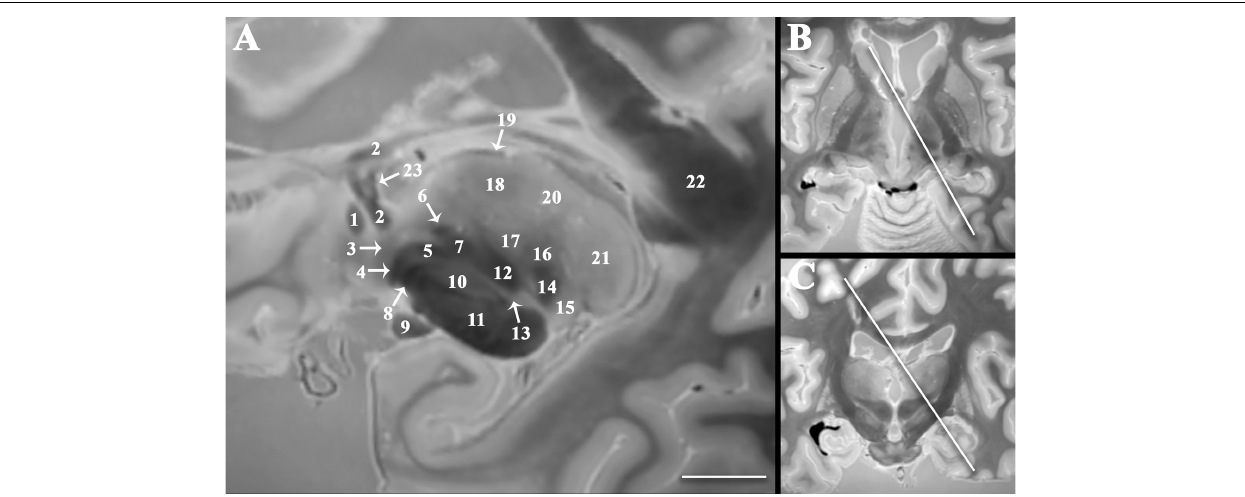
FIGURE 3 | Double oblique sagittal image oriented orthogonal to the thalamic termination of the dentatorubrothalamic tract (A) to improve visualization of the spatial relationships between the subthalamic region, cerebellothalamic, and pallidothalamic pathways important to emerging functional neurosurgery treatments for movement disorders. Panel (B) demonstrates angulation in the axial plane 35 o relative to the sagittal plane (anteromedial-to-posterolateral). Panel (C) demonstrates angulation in the coronal plane 30 o relative to the sagittal plane (superomedial-to-inferolateral). Labeled structures include anterior commissure (1), fornix (2), ansa peduncularis (3), ansa lenticularis (4), lenticular fasciculus (5), thalamic fasciculus (6), H field of Forel (7), pallidonigral tract (8), optic tract (9), subthalamic nucleus (10), cerebral peduncle (11), dentatorubrothalamic tract (12), zona incerta (13), medial lemniscus (14), medial geniculate nucleus (15), ventral posterior nucleus (16), ventral intermediate nucleus (17), ventral lateral nucleus (18), stria medullaris (19), dorsomedial nucleus (20), pulvinar (21), splenium of corpus callosum (22), and direct fornix projection to the anterior thalamic nucleus (23) [scale bar = 10